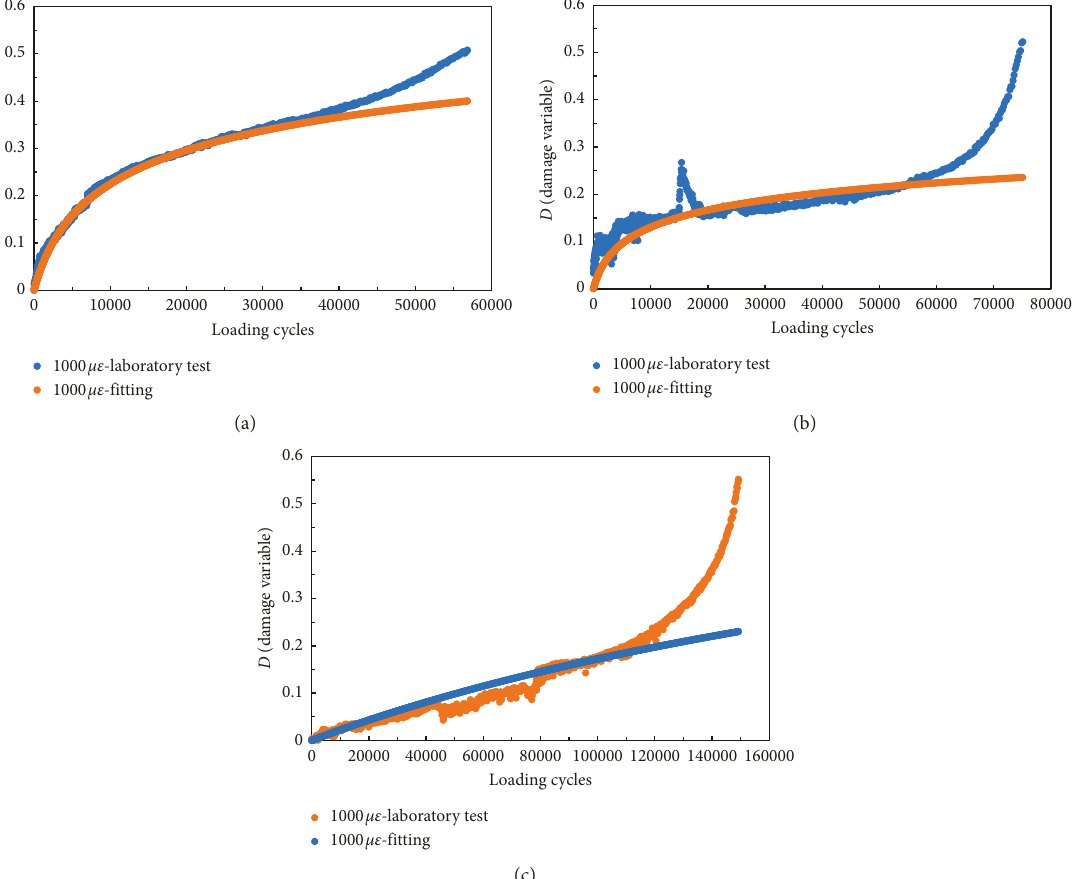
Figure 8: Fatigue performance prediction of the asphalt mortar at 10 ° C: (a) low asphalt content; (b) moderate asphalt content; (c) high asphalt